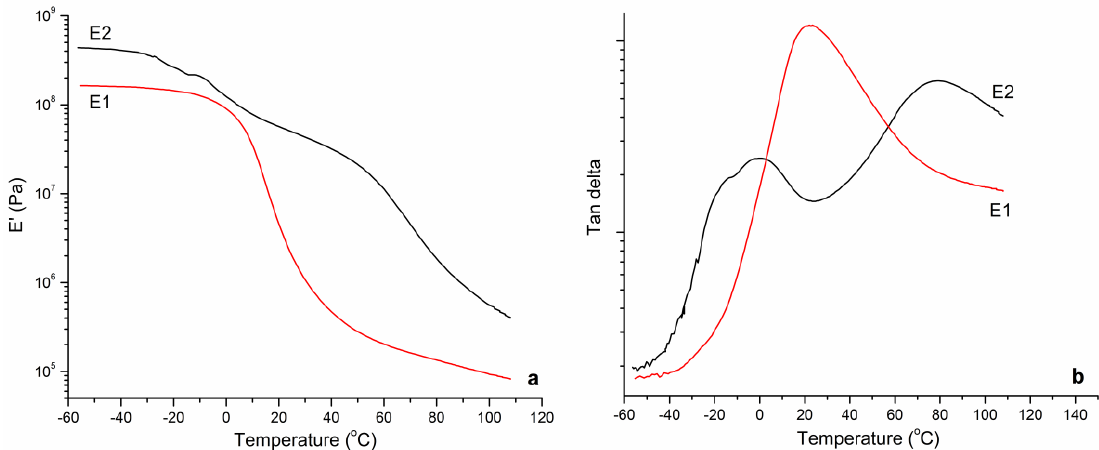
Figure 5. The elastic modulus ( a ) and Tan — D curves ( b ) of the copolymer films obtained from DMTA.